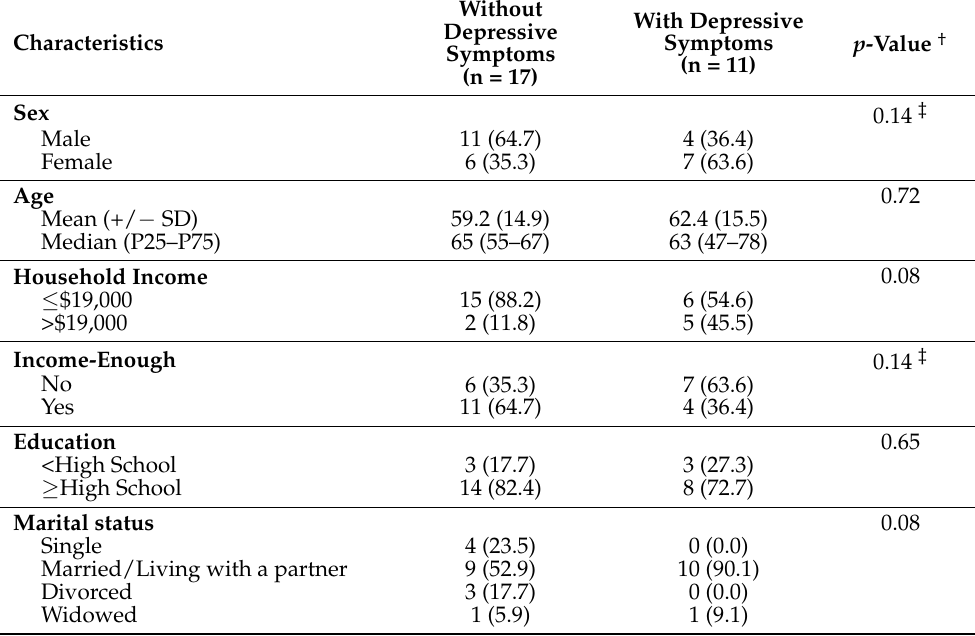
Table 2. Association between socio-demographic characteristics and presence of depressive symp- toms (n =